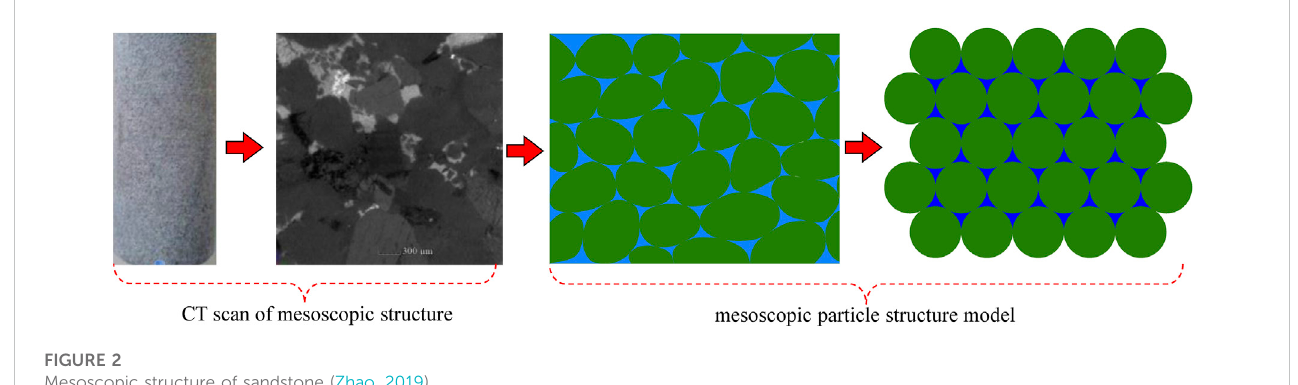
FIGURE 2 Mesoscopic structure of sandstone (Zhao,